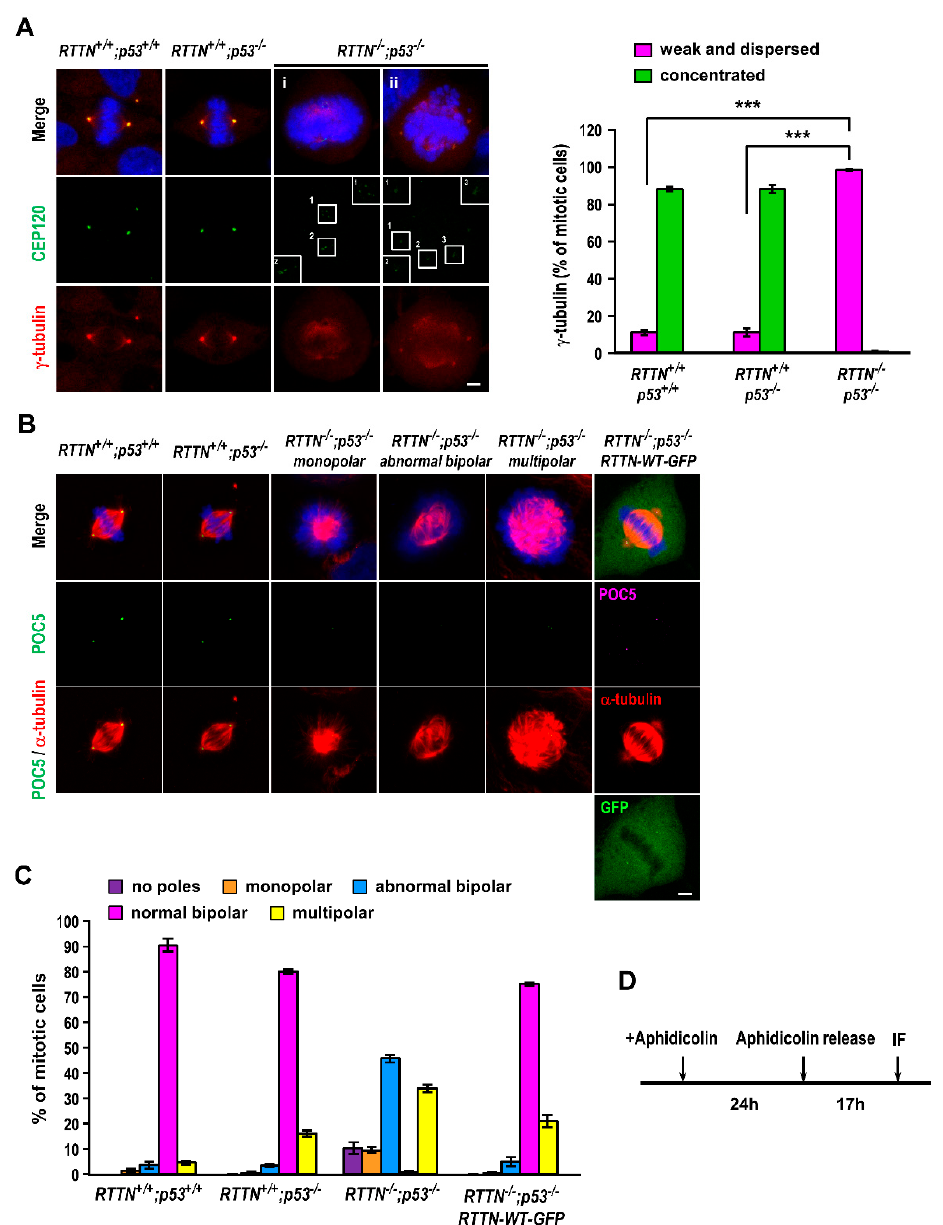
Figure 1. RTTN depletion resulted in multiple mitotic abnormalities. RPE1-based RTTN +/+ ; p53 +/+ , RTTN +/+ ; p53 − / − , or RTTN − / − ; p53 − / − mitotic cells were immuno-stained with antibodies against CEP120 and γ -tubulin (( A ), the quantitation of γ -tubulin distribution pattern is shown in the right panel), or POC5 and α -tubulin ( B ). DNA was counterstained with DAPI. In ( B ), the mitotic abnormalities in a portion of RTTN − / − ; p53 − / − cells can be effectively rescued to normal bipolar spindles by exogenously expressing the RTTN -WT-GFP construct. ( C ) Histograms illustrating the percentages of mitotic cells with indicated mitotic phenotypes. ( D ) Schematic of the procedure used to enrich mitotic cells. Data are represented as the mean ± SEM from four independent experiments. Scale bars: 5 µ m. *** p <